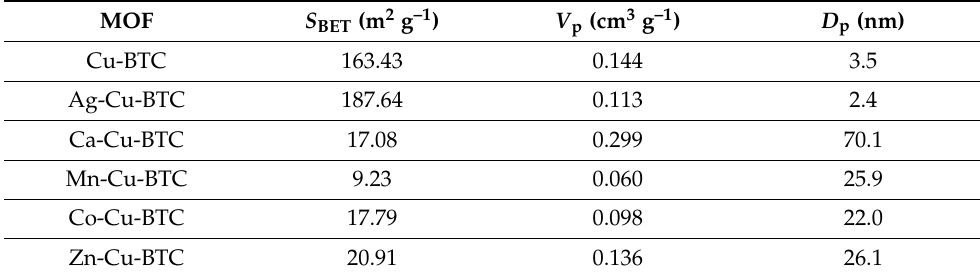
Figure 2. ( a ) PXRD patterns; ( b ) TGA profiles; ( c ) FTIR spectra; ( d ) N 2 adsorption–desorption curves of MOFs. Table 1. Surface area and pore characteristics of